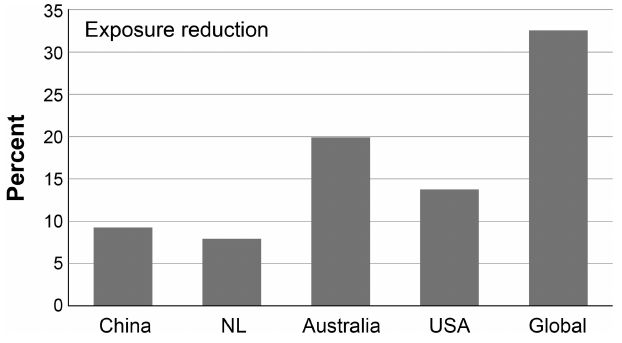
Fig. 2 . The relative importance of exposure reduction